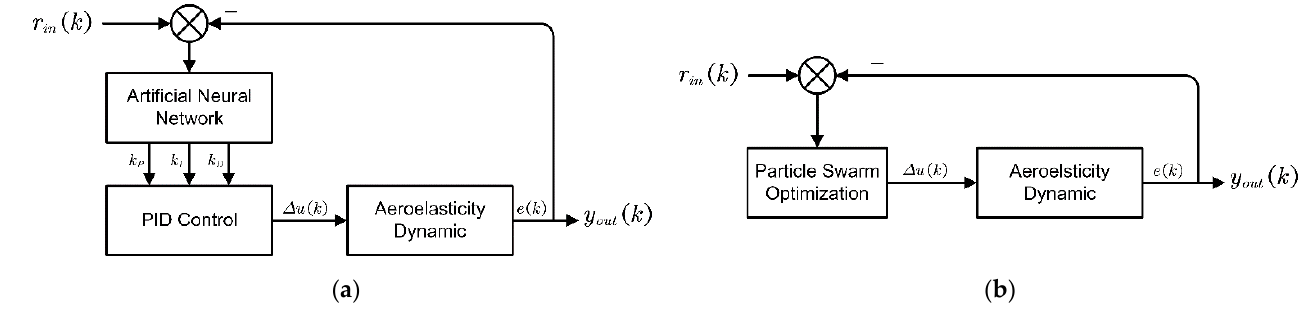
Figure 2. Comparison of two control methods. ( a ) Fuzzy neural network combined with PID control; ( b ) particle swarm optimization.